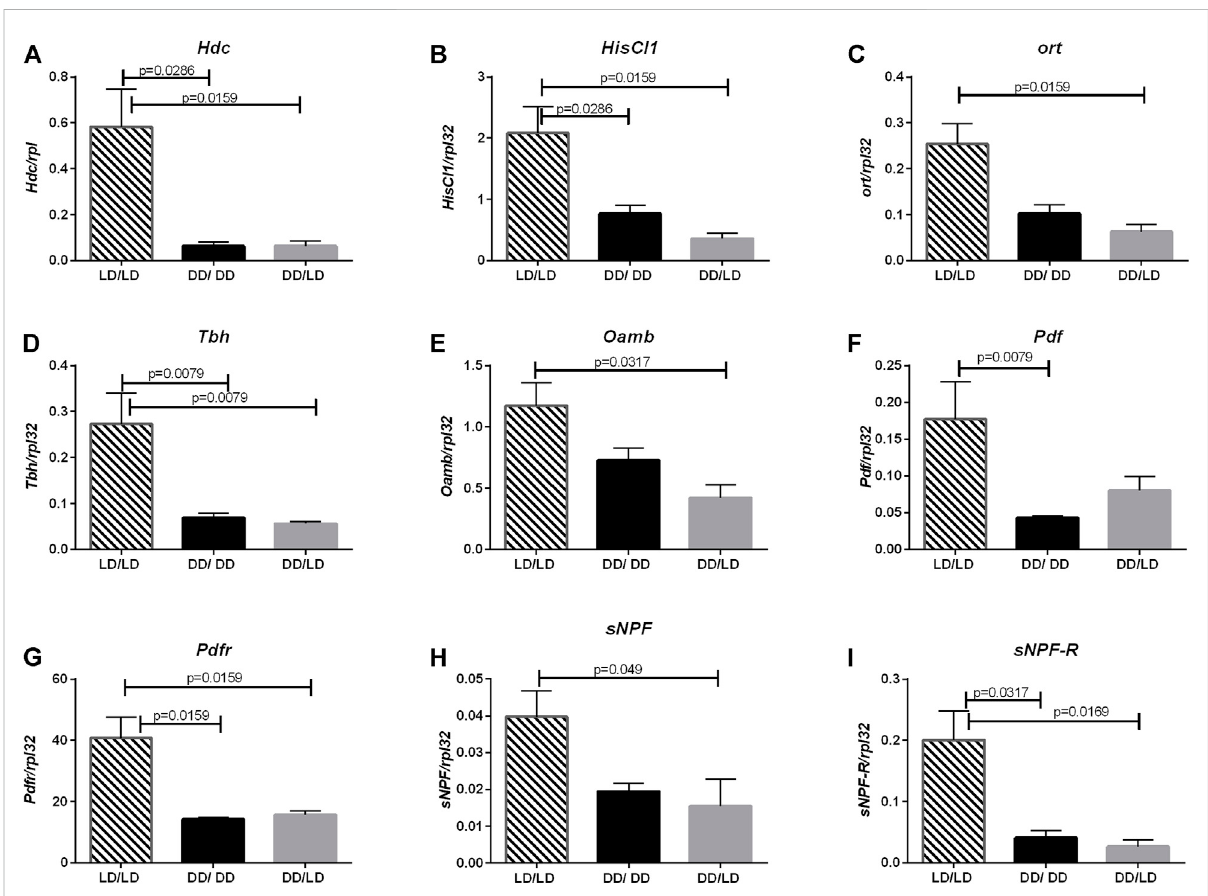
FIGURE 3 Lack of light changes neurotransmitters signaling level. qPCR analysis ofexpressionlevel ofgenes connected with histamine, octopamine, PDF and sNPF signaling for fl ies maintained in normal conditions LD12:12 (LD/LD), maintained in DD and developed in darkness (DD/DD) and after eclosiontransferredtoLD12:12(DD/LD).Expression checkedfor: (A) histidinedecarboxylase ( Hdc ), (B) receptor HisCl1 , (C) receptor Ort. (D) Tbh and (E) receptor Oamb, (F) Pdf , (G) Pdfr , (H) sNPF and (I) sNPF-R. N = 5. Mean ±